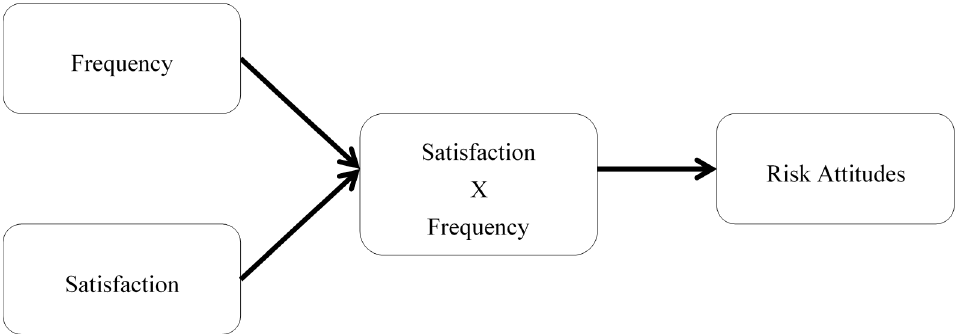
Figure 3. Conceptual Dynamic Relationship between Risk and